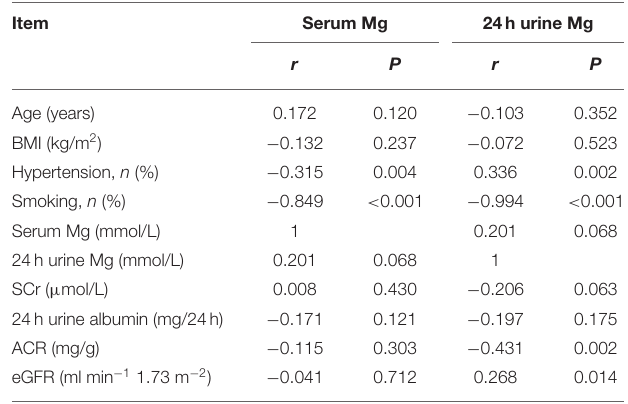
TABLE 5 | Correlation coefficients between Zn and clinical parameters and indices of renal function in DN patients.